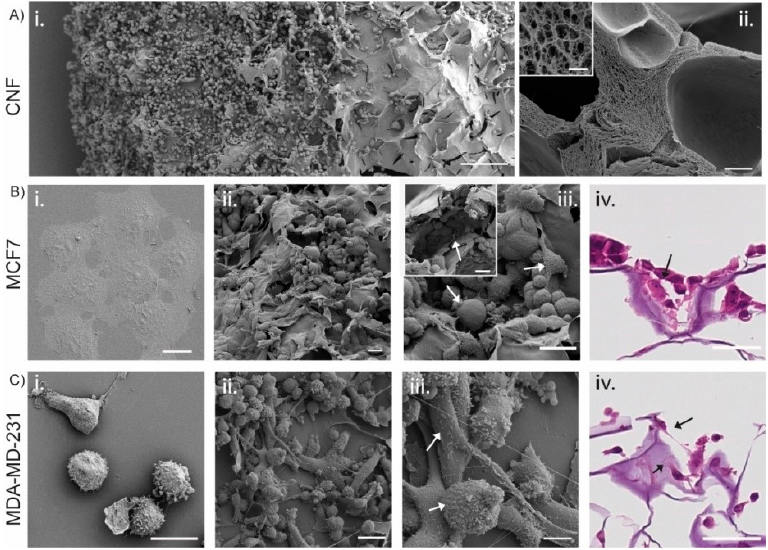
Figure 4. Cells cultured on TEMPO-CNF develop a heterogenous cell population with different cell morphologies. ( A , B ( i – iii ), C ( i – iii )) SEM images of ( A ) TEMPO-CNF material in ( i ) low magnification overview with MDA-MB-231 cells and ( ii ) cross section and cavities in the material. Inset in ( A ( ii )) higher magnification of the cross section. ( B ) MCF7 and ( C ) MDA-MB-231 cells. ( B ( i ), C ( i )) Cells grown in 2D cell culture plates in a homogenous mono layer. ( B ( ii , iii ), C ( ii , iii )) illustrates cells grown in multiple layers with different morphologies (indicated by white arrows in ( B ( iii ), C ( iii )). Inset in Biii shows cells filling out holes and cavities in the TEMPO-CNF material. ( B ( iv ), C ( iv )) Hematoxylin and eosin-stained sections of TEMPO-CNF scaffolds with MCF7 and MDA-MB-231, respectively. Black arrows indicate the cells. Scale bars 200 μ m ( Ai ), 20 μ m ( Bi , Ci ), 10 μ m ( A ( ii ), C ( iii )), 1 μ m (inset in ( A ( ii ))), 10 μ m ( C ( iv )), 30 μ m (( B ( ii – iv ), C ( ii )), inset ( B ( iii ))).